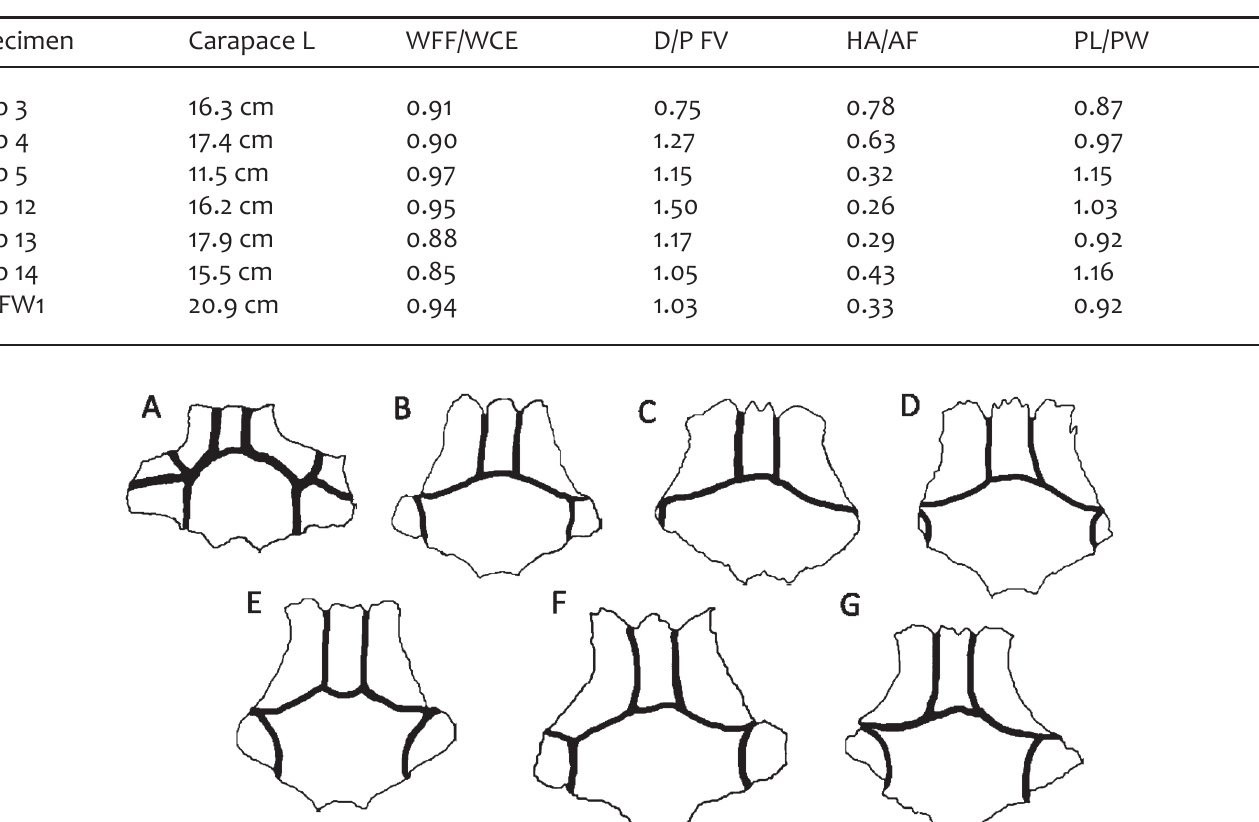
Figure 8. Nuchal bones of Chrysemys picta bellii. A, Neb 3; B, Neb 4; C, Neb 5; D, Neb 12; E, Neb 13; F, Neb 14; and G, ODFW